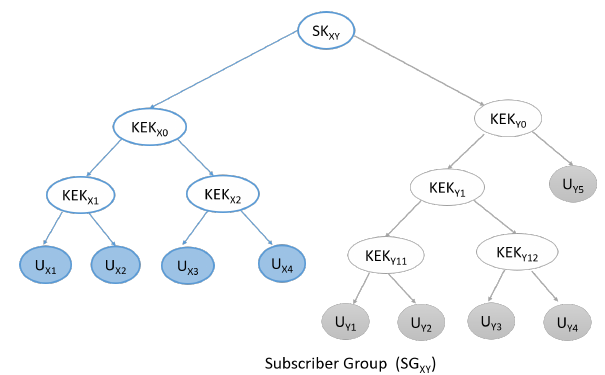
Figure 9. The figure shows the inner LKH tree of the group SG XY obtained by merging of the SGs SG X and SG Y . Note that SK XY is securely multicast to U X1 , U X2 , U X3 and U X4 by encrypting it using KEK X0